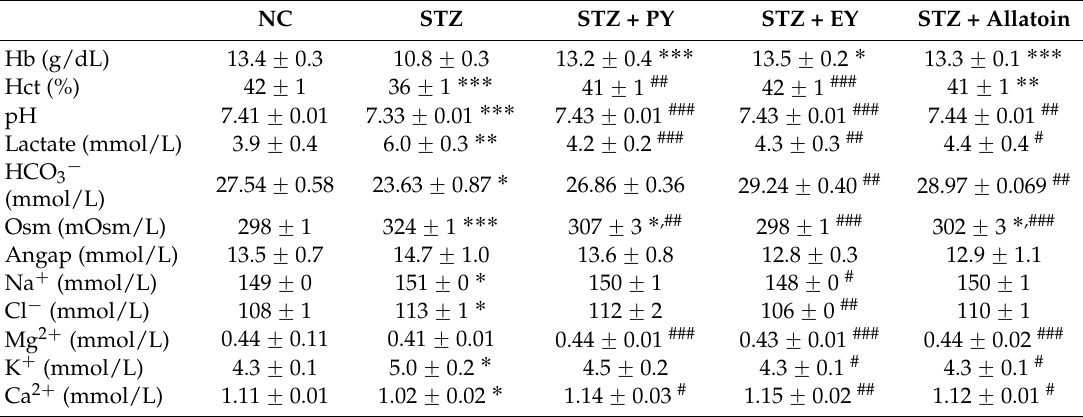
Table 1. Effects of PY, EY, and allantoin on the blood hemoglobin concentration, hematocrit value, and electrolytic balance in STZ ‐ induced diabetic rats.